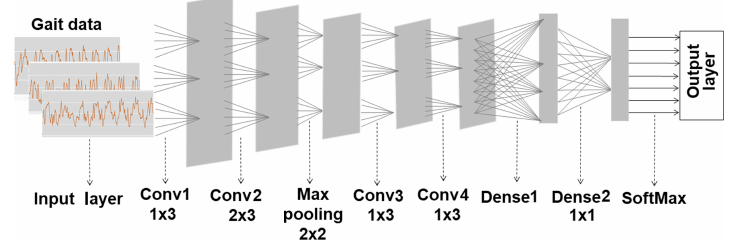
Fig. 4 CNN-GR infrastructure.